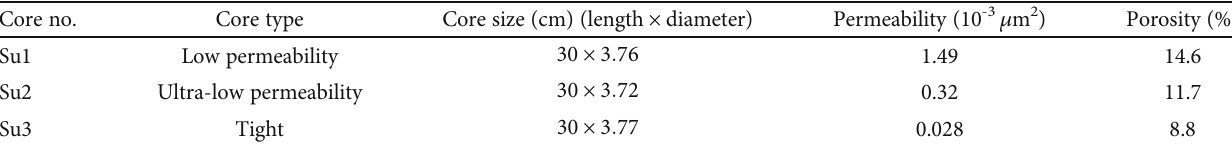
Table 1: Basic properties of tight sandstone cores.